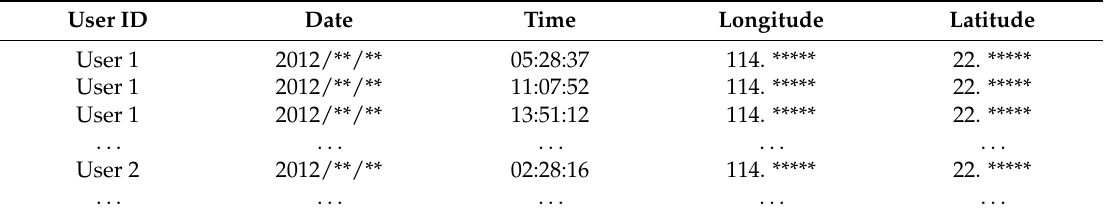
Table 1. Example of individuals’ cell phone records during a day.